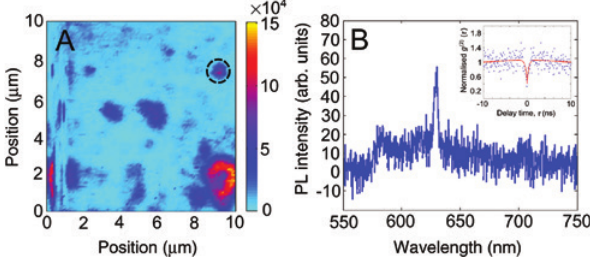
Figure 4: (A) Representative 10 × 10 μ m 2 confocal scan of the 700 ° C annealed ZnO NPs removed from the SiO substrate and redeposited 2 onto a Si substrate. The optical defect in the centre of the dashed circle was characterised. (B) Spectrum of the circled defect. The integration time was 30 s and was chosen due to a concern that the defect would photobleach. The inset shows the normalised g (2) his- togram (blue points) along with a three-level model fit (red line) at a pump power of 0.67 ± 5 × 10 -3 mW. The time bin was 512 ps, with an integration time of 600 s, and the count rates at the detectors were 7 and 20 kc/s with a background count of 2 kc/s